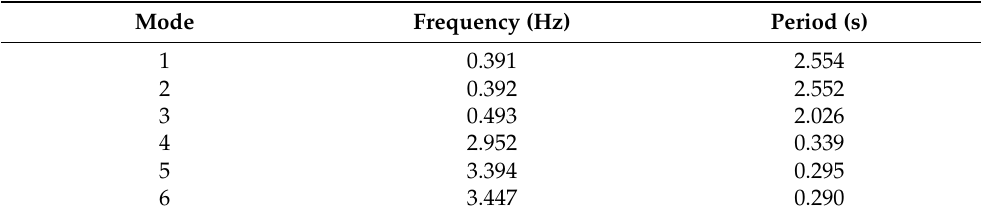
Table 6. Results of the modal